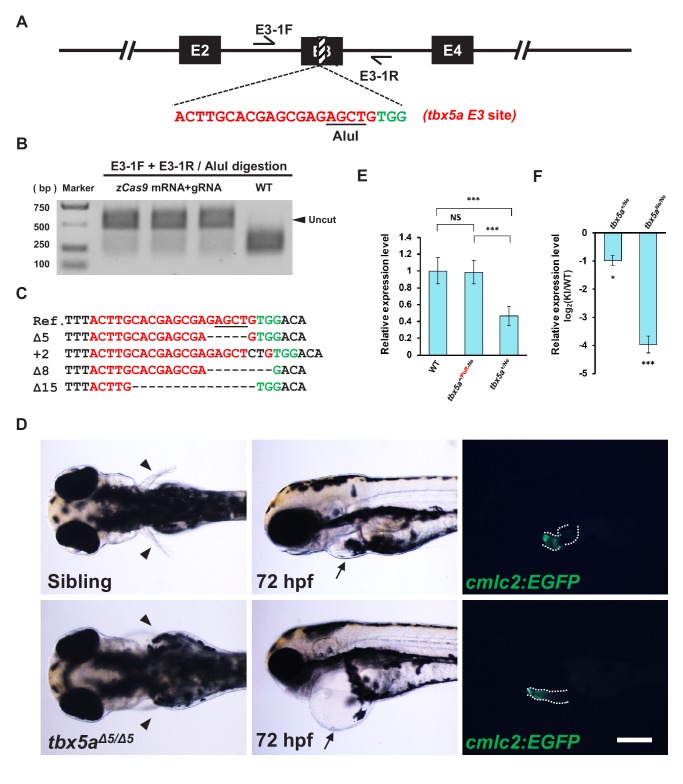
Evaluation of the indel efficiency of the tbx5a E3 target site and phenotype analysis of the tbx5a indel mutation.(A) The position and sequence of the tbx5a exon 3 (E3) target site designed for the Cas9/gRNA system. The protospacer sequence is shown in red, and the PAM is shown in green. (B) Targeting efficiency evaluated by PCR and AluI restriction endonuclease digestion. The result indicates that the indel efficiency is nearly 90%. (C) Sequencing results of the uncut PCR products (corresponding to indel mutations) from B after cloning. (D) Approximately 25% of embryos from the incross of tbx5a+/Δ5 heterozygotes showed defects in heart (black arrows) and pectoral fins (black arrowheads). Genotyping results revealed that all the defective embryos were tbx5aΔ5/Δ5 homozygotes (lower panel), while the siblings showed a normal morphology. The Tg(cmlc2:EGFP) transgenic background was introduced to reveal the heart morphology, and all the defective embryos also showed failure of cardiac looping. The dotted lines denote the outline of the heart. Scale bar, 200 μm. (E) qRT-PCR results showing the transcription level of the tbx5a locus in wild-type (WT) and tbx5a PoR-Ne donor KI zebrafish embryos at 72 hpf, using T5qF and T5qR primers. The tbx5a+/Ne and tbx5a+/PoR-Ne embryos were obtained from the crossing of the tbx5a PoR-Ne/PoR-Ne homozygotes with wild-type zebrafish with or without injection of Cre mRNA, respectively. The average expression level of wild-type embryos was set as 1. (F) qRT-PCR results using T5qF and T5qR primers, showing the transcription level of the tbx5a locus in the tbx5a+/Ne and tbx5aNe/Ne embryos derived from the Cre mRNA-injected tbx5a+/PoR-Ne and tbx5aPoR-Ne/PoR-Ne embryos, respectively. The original embryos were obtained from the crossing of tbx5aPoR-Ne/PoR-Ne homozygotes with tbx5a+/PoR-Ne heterozygote zebrafish. The expression levels in the KI embryos were normalized to the WT ones. Data are presented as the mean ±s.d., and a two-tailed Student’s t-test was applied to calculate p values in all the experiments. *: p<0.05. ***: p<0.001. NS: Not significant.